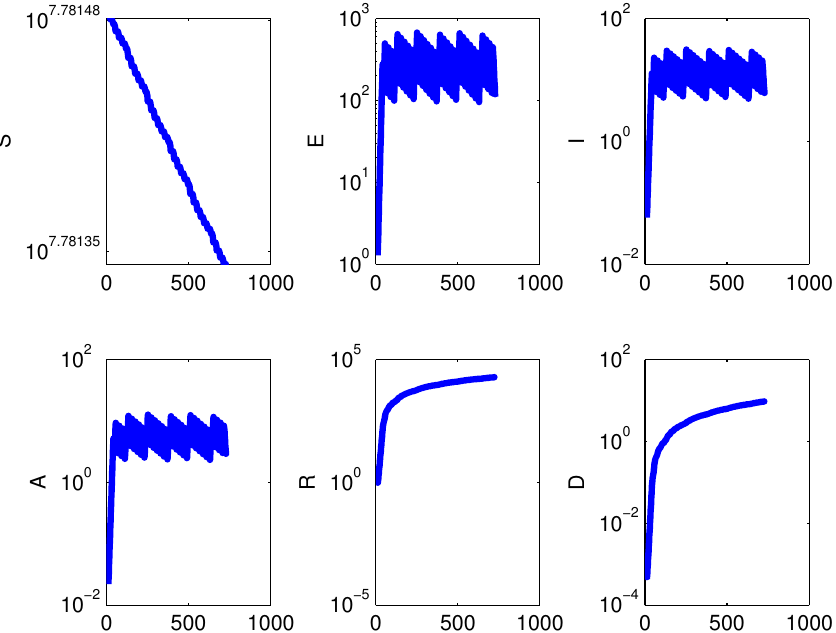
Figure 16. Using a semilogarithmic scale for the vertical axis, we show the results of the intermittent lock-down policy, implemented from time 1. Here the population is checked every week. If the number of infected is above a small threshold (here taken to be 10) the reduced contact rate β I = 10 − 10 is resumed for a week. The simulation runs over two years timespan for the simplified model with no demographics (1) where we take Λ = 0, d p = 0. Left to right and top to bottom, the subpopulations are: S , E , I , A , R and D , the disease-related deceased